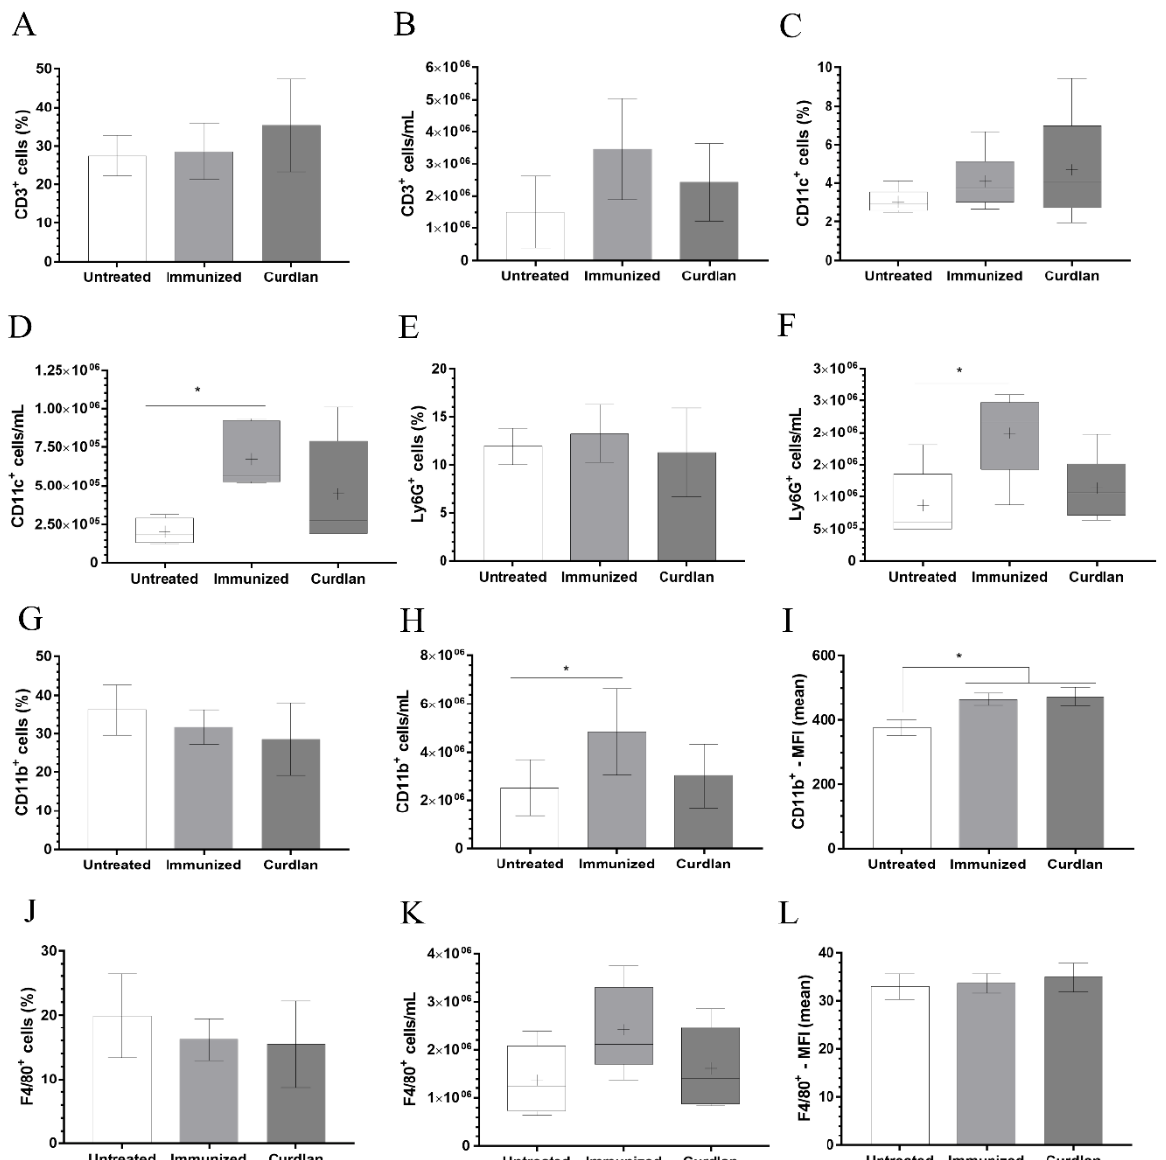
Figure 5. Phenotyping of the leukocytes in the lungs of mice treated with curdlan and immunized with HK- C. gattii . After administration of curdlan or PBS, the mice were immunized with HK- C. gattii -thin and infected with viable C. gattii . The lungs of the infected mice were harvested at 14 days post infection. Pulmonary leukocytes were obtained by dissociating the tissue with collagenase. The cell suspensions were used to determine the frequency (%) and concentration (cell/mL) of T lymphocytes ( A , B ), CD11c + ( C , D ), Ly6G + ( E , F ), CD11b + ( G , H ), and F4/80 + ( J , K ). The mean fluorescence intensity (MFI) of ( I ) CD11b + and ( L ) F4/80 + cells was recorded using flow cytometry. The relative and absolute frequencies of these cells were determined in the lung samples. The results are expressed as both, in percentage and cells/mL, and are represented as mean ± SD or as median with maximum and minimum values. Comparisons were made between groups for the same period of infection. * p <